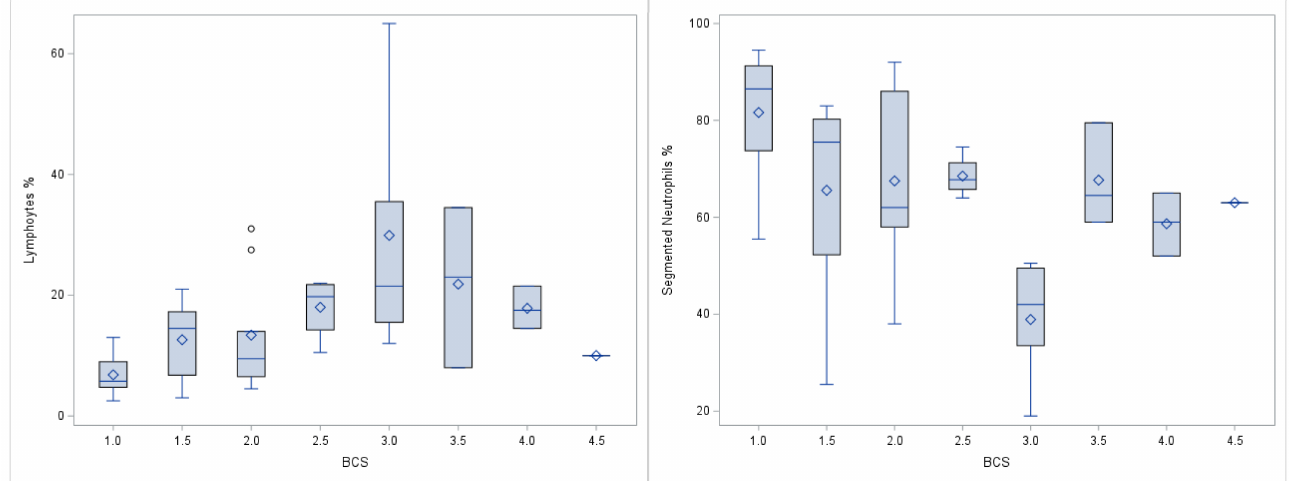
Figure 2. Proportions of lymphocytes ( left ) and segmented neutrophils ( right ) in llamas (n = 41) with different BCS. The boxplots display the quartile range and the respective minimum and maximum.